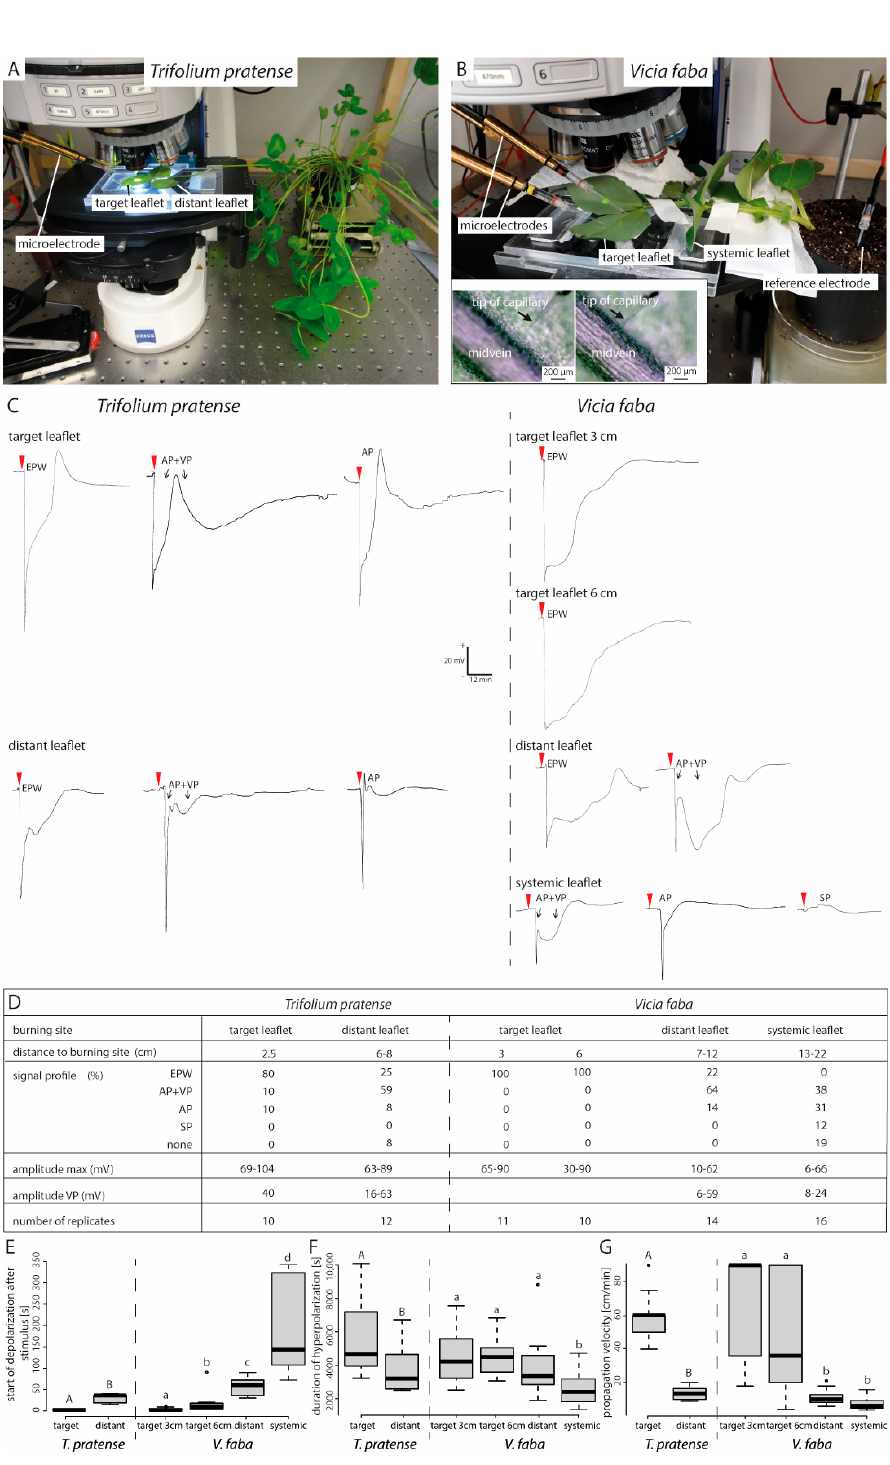
Figure 5. Electrophysiological reactions in response to local, distant and systemic heat stimulation of V. faba and T. pratense leaf tips. ( A , B ) for extracellular, electrophysiological measurements the tip of a glass capillary was pierced into lower side of the midvein of a V. faba or T. pratense target leaflet under microscopical surveillance to ensure a correct placement (see inset B). ( C ) Typical recordings of electrophysiological reactions at the target leaflet are shown for stimulation of target, distant and systemic leaflets. Scale bar in ( C ) is valid for all measurements. ( D – G ) Parameters of the recorded electrophysiological reactions in the respective leaflets are arranged side by side. ( E ) represents the start of the depolarization after the stimulus, ( F ) the duration of the depolarization and ( G ) the propagation velocity. Statistical values are shown in Tables S4 and S5. Different letters indicate significant differences. AP—action potential, VP—variation potential, SP—system potential, EPW—electropotential